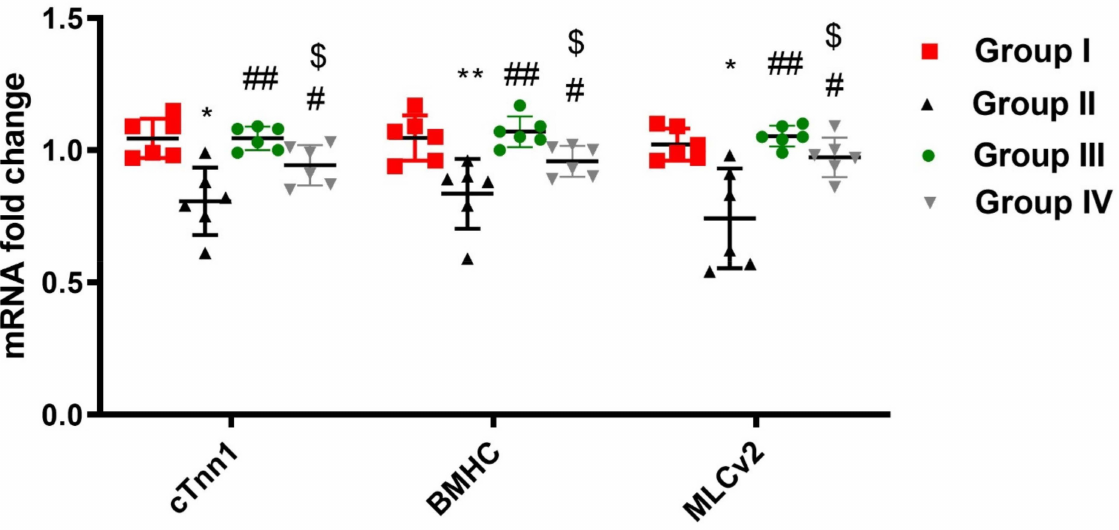
Figure 3. Effect of ADMSCs-derived exosomes on DOX/Trz-induced myofibril loss. Cardiac mRNA levels of cTnn1, BMHC, and MLCv2. Data expressed as median (maximum, minimum). *, significant compared to Group I at p < 0.05; **, significant compared to Group I at p < 0.01; #, significant compared to Group II at p < 0.05; ##, significant compared to Group II at p < 0.01; $, significant compared to Group III at p < 0.05; n =